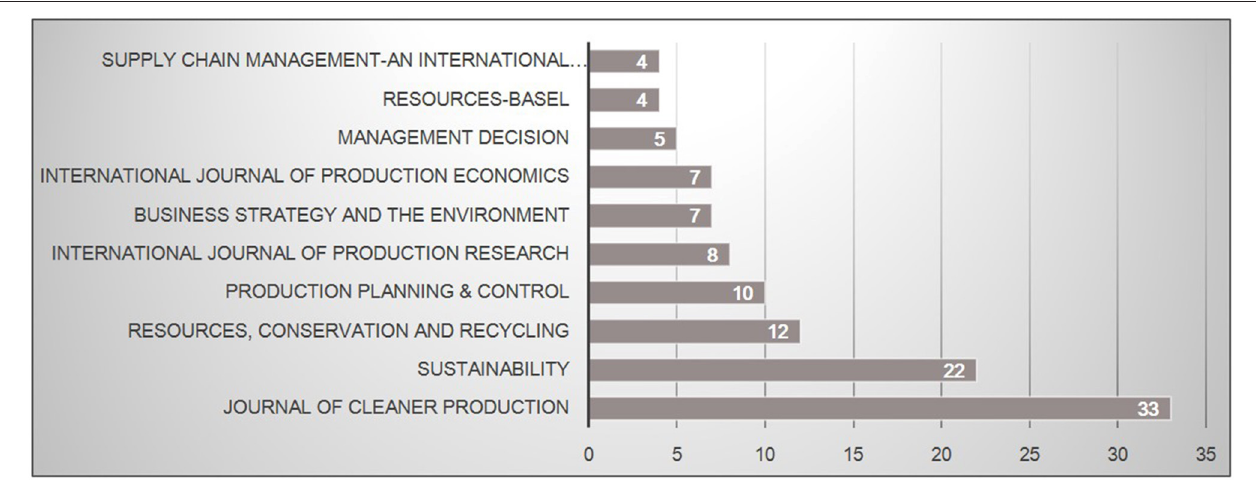
FIGURE 6 | Distribution per source title (top